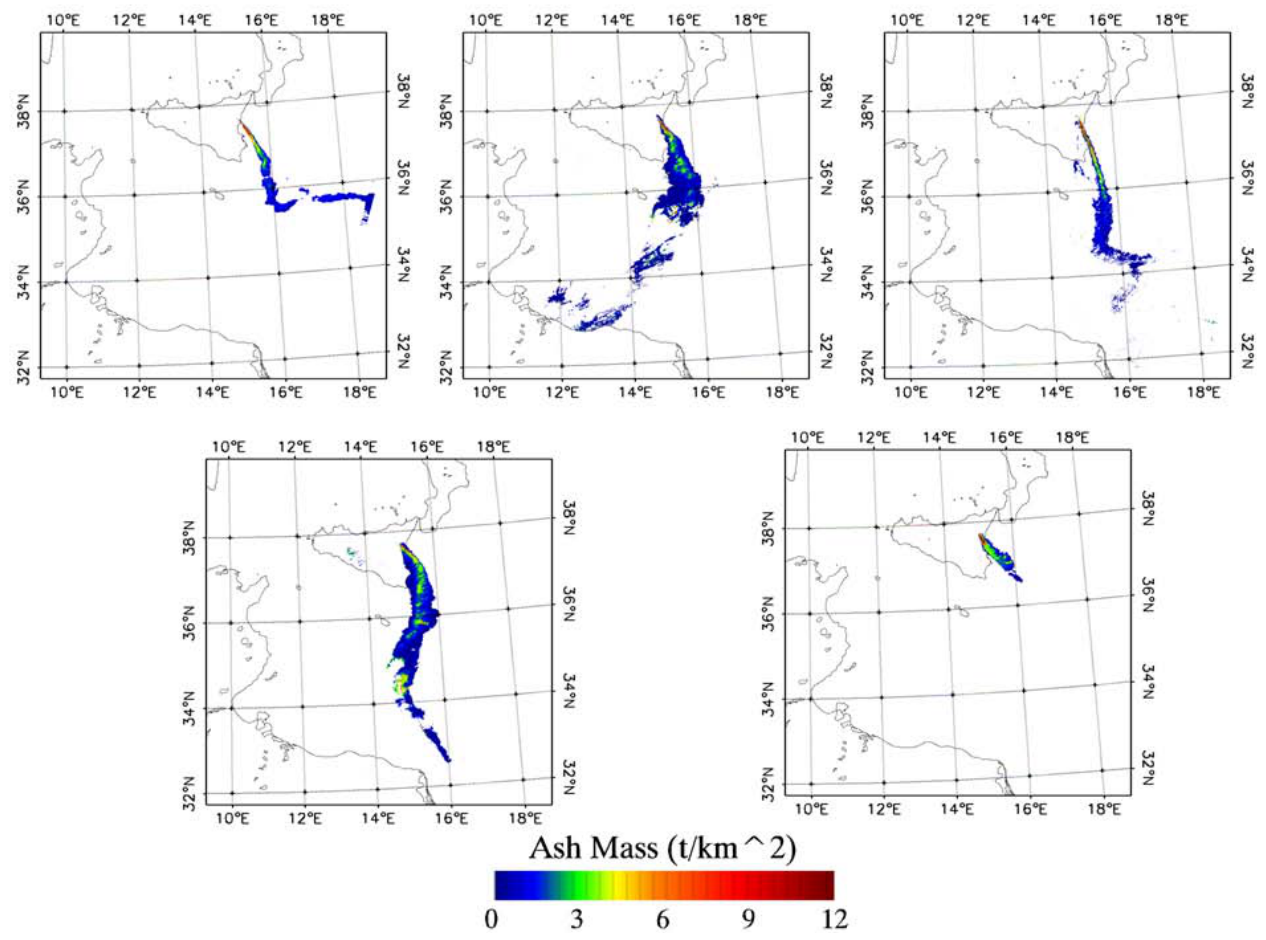
Fig. 3. MODIS BTD ash retrieval maps. Top Plates, from left to right: 23 July 2001, 28 October 2001 and 29 October 2002. Bottom Plates, from left to right: 30 October 2002 and 24 November